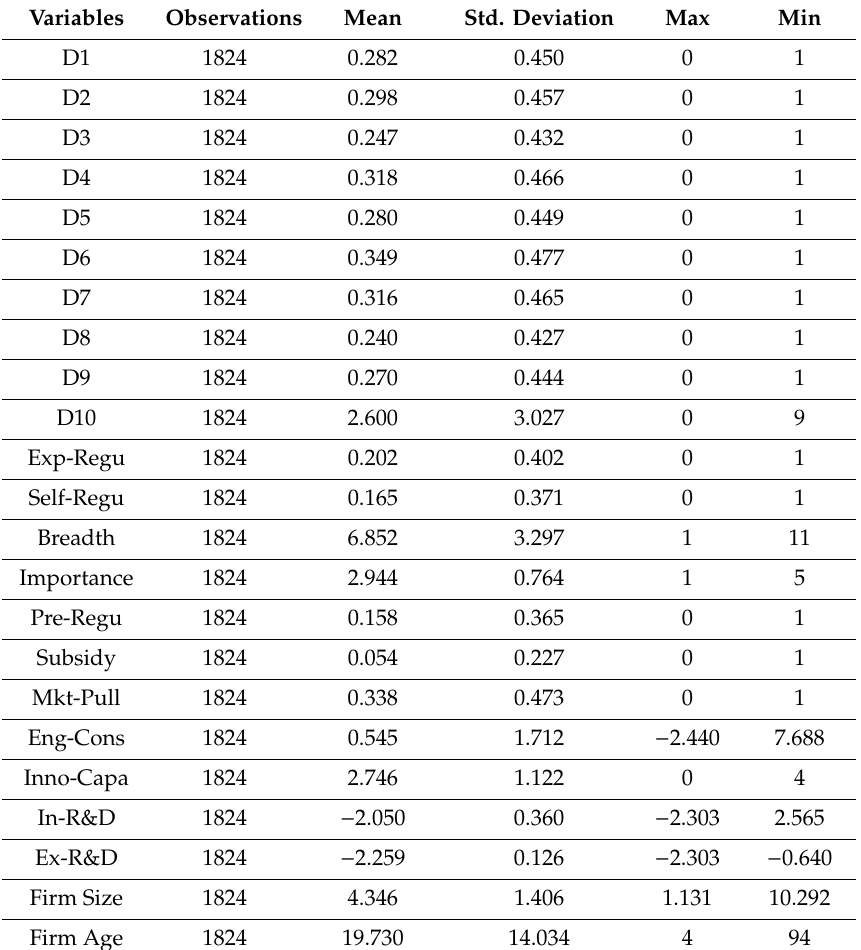
Table 2. Descriptive